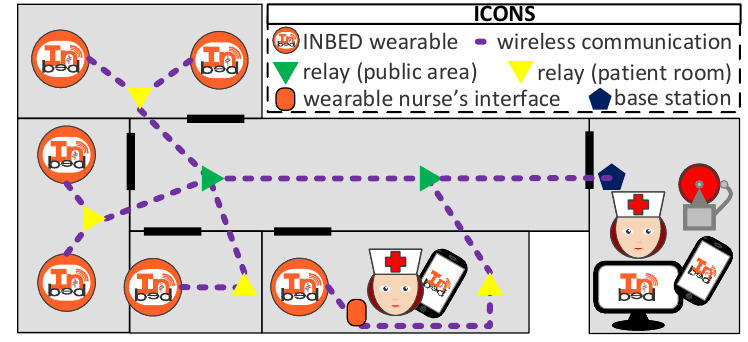
Figure 4. Floor plan of an exemplary ward with installed INBED system communication